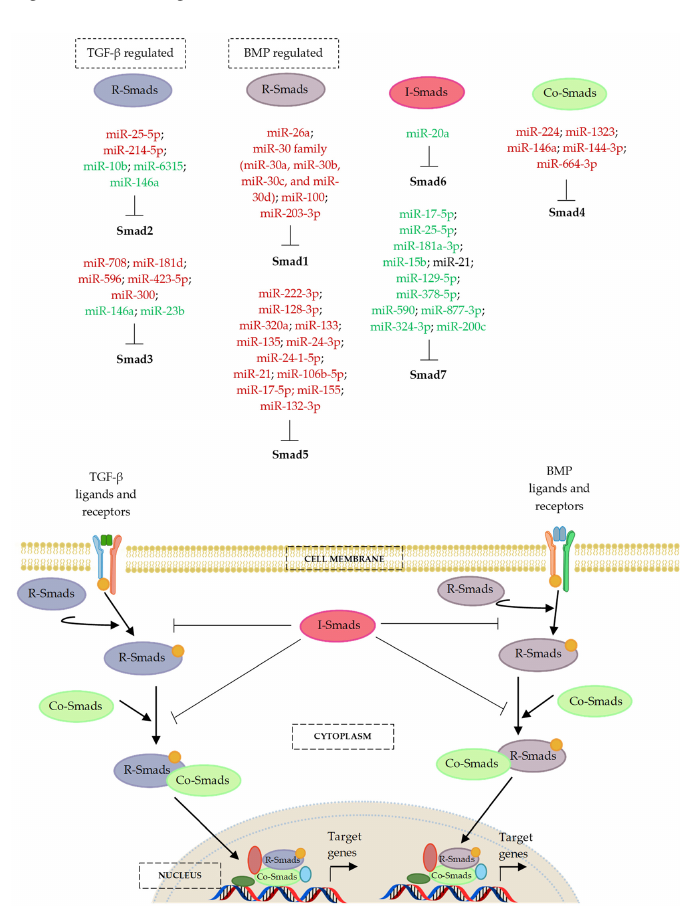
Figure 5. MicroRNAs regulating components of the Smad signalling pathway. Notes: MicroRNAs in green indicate positive regulation on osteogenesis, and microRNAs in red indicate negative regulation on osteogenesis.